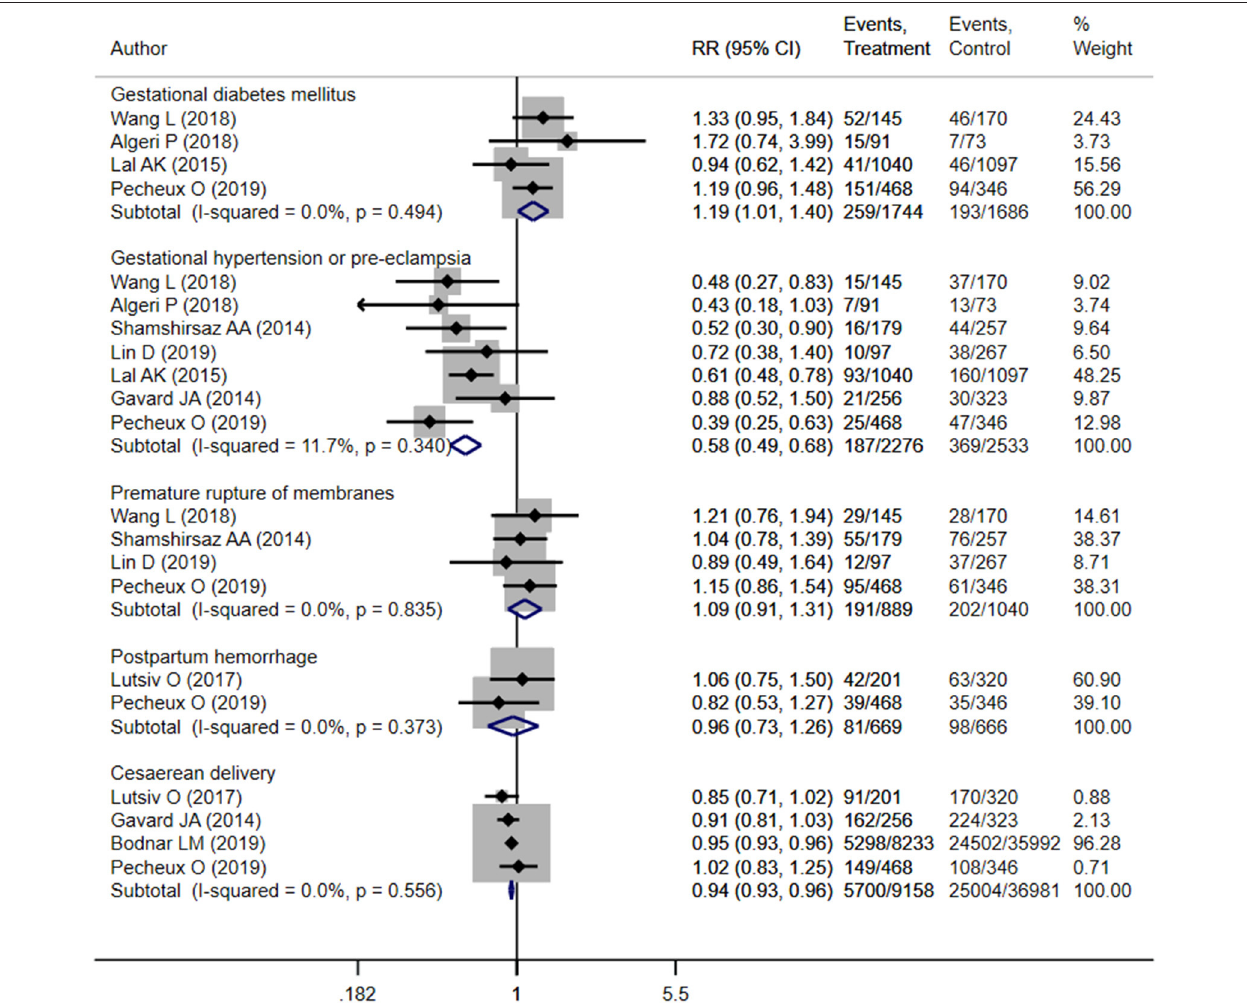
FIGURE 2 | Pooled analysis of inadequate or adequate pregnancy weight gain effects on maternal health outcomes.